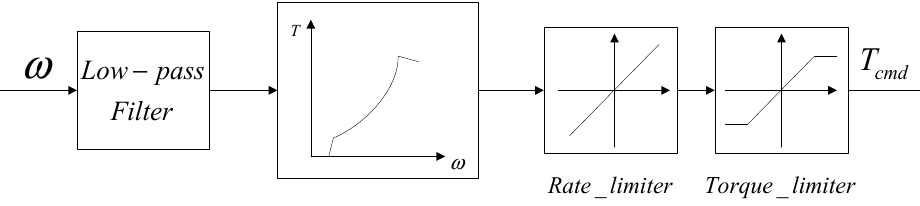
Figure 3. Schematic diagram of converter torque command